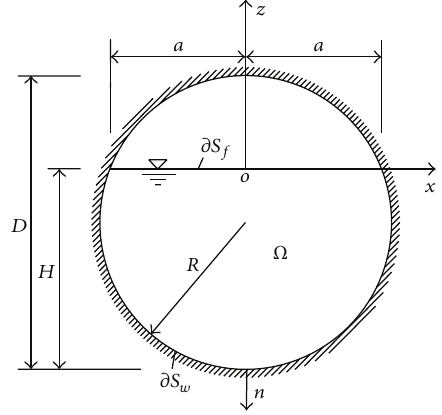
Figure 6: A circular-section